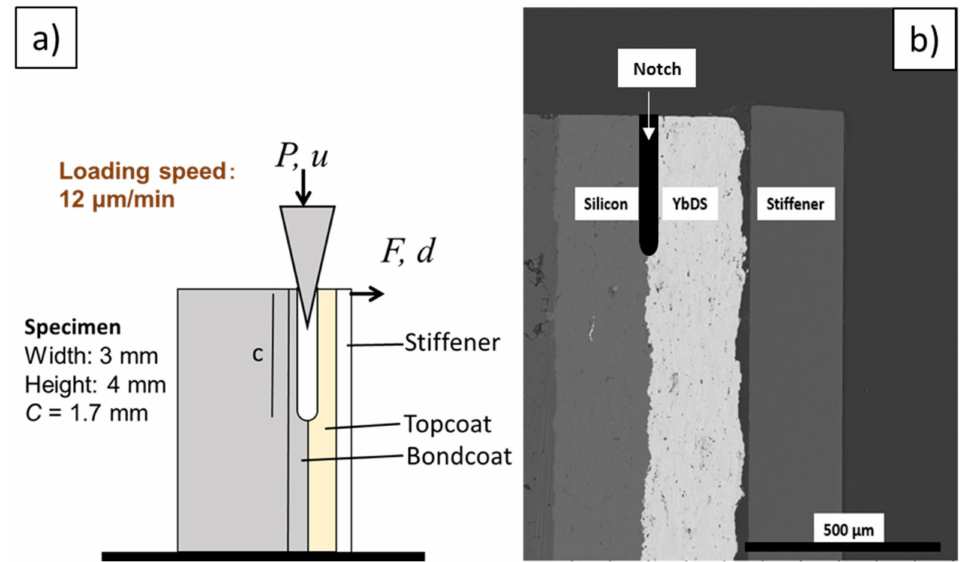
Figure 2. Draft of the original test setup ( a ) and a SEM picture of a prepared sample for the interface toughness test ( b